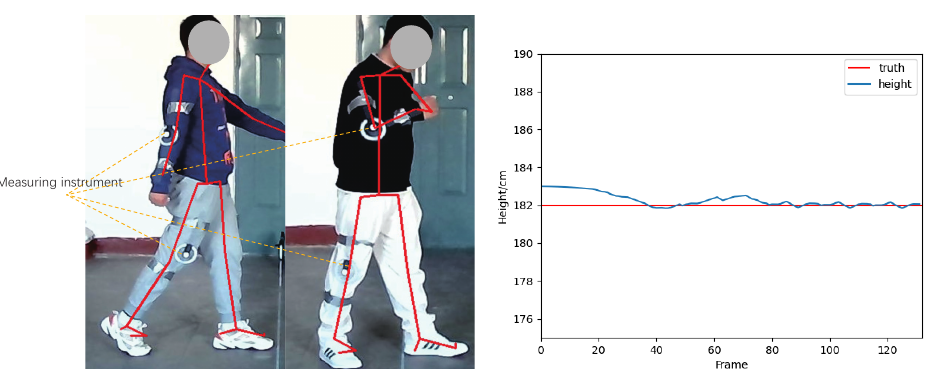
Figure 10. HPI evaluation. Left image: the ground truth value of A GT is obtained through the medical instrument that is fixed on the test part of the human. Right image: Kalman filter is applied during the dynamic measurement experiment to compress the effect of random noise